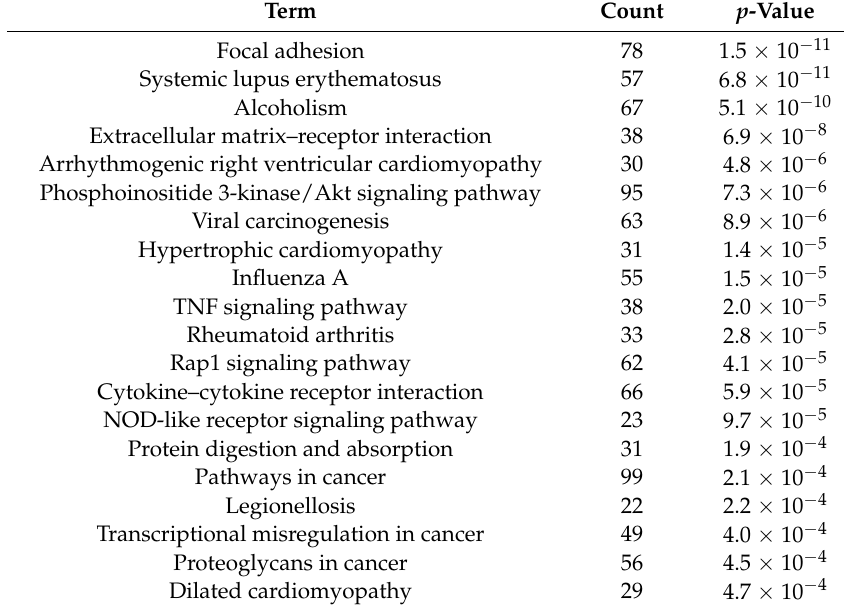
Table 2. Kyoto Encyclopedia of Genes and Genomes (KEGG) pathway functional classification of genes differentially expressed in LX-2 cells after treatment with deoxycholic acid (DCA) and lipoteichoic acid (LTA) for 48 h. Akt—protein kinase B; TNF—tumor necrosis factor; Rap1—Ras-proximate 1; NOD—nucleotide-binding oligomerization